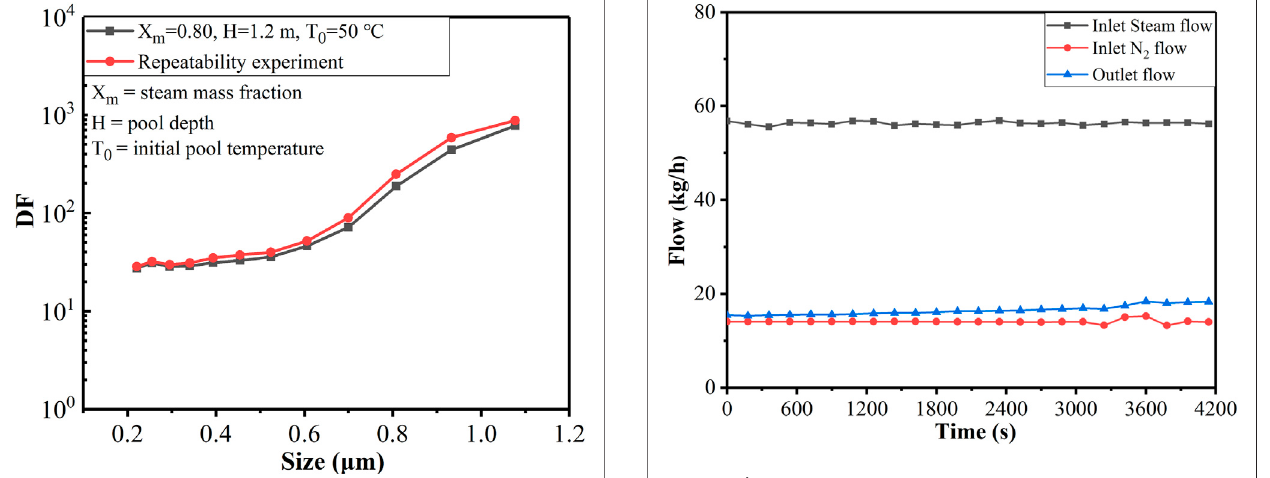
FIGURE 3 | Mass fl ow rate of steam and nitrogen at the inlet and outlet.